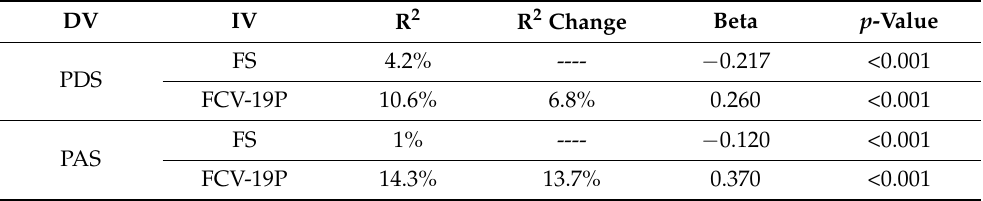
Table 5. Hierarchic linear regression analyses of the fear of COVID-19 on depressive and anxious symptoms reported by Group